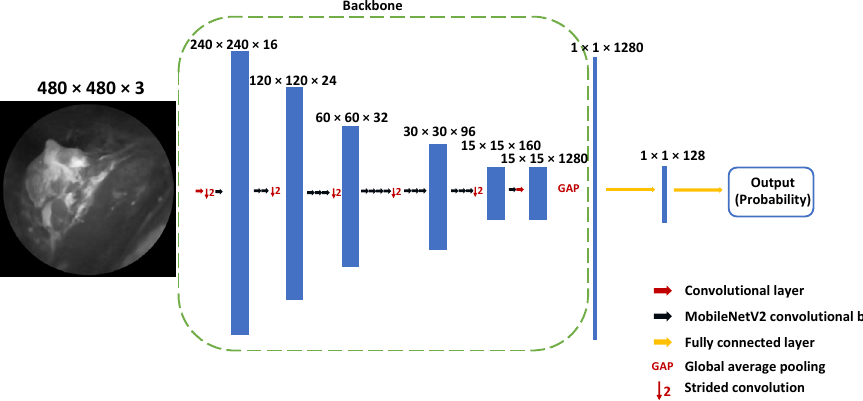
Figure 2. Suspicious frame selection model architecture with MobileNetV2 backbone.